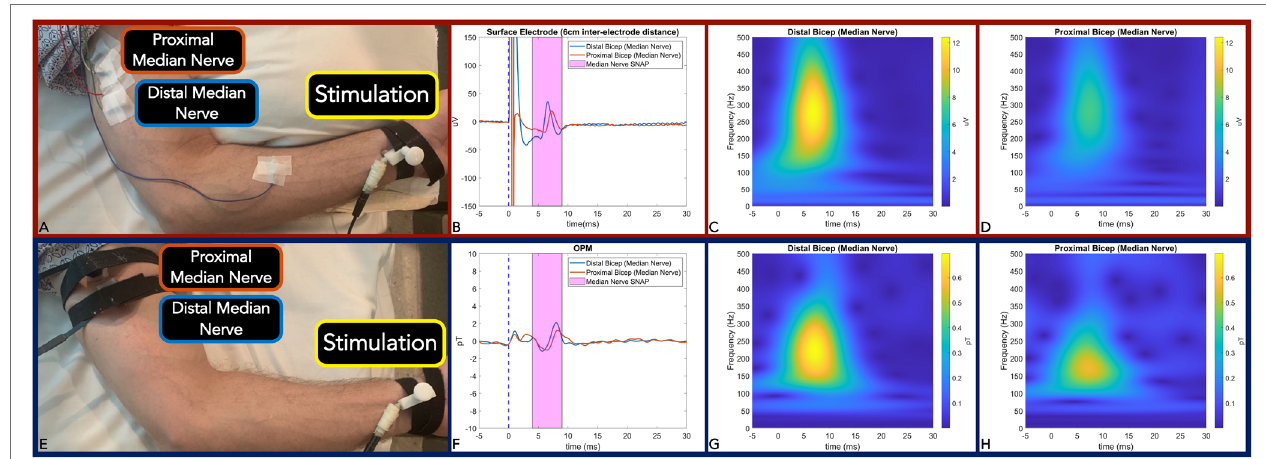
FIGURE 1 | Panel (A,E) : Measurement setup of Median nerve SNAP with surface electrode (A) and equivalent action current by OPM (E) . Panel (B,F): Time-locked average comparison (from two sites: distal bicep = blue line; and proximal bicep = red line) between surface electrode (6 m inter-electrode distance) (B) and OPM (F) demonstrate identical 0.8 ms temporal dispersion for both modalities. SNAP action potential/currents are marked in the magenta shaded area. Panel (C,D) : Surface electrode time-frequency analysis for SNAP measured at the distal bicep (C) and proximal bicep (D) . Panel (G,H) : OPM time-frequency analysis for SNAP measured at distal bicep (G) and proximal bicep (H) . (OPM, Optically pumped magnetometers, SNAP, Sensory nerve action potential, μ V, microvolt, pT, picoTesla, and ms,